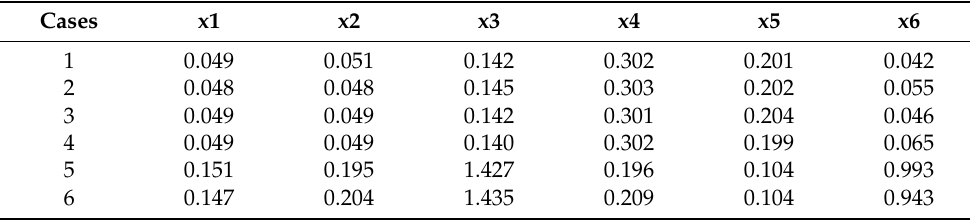
Table 4. Calculated average concentration of Cu in scrap, C Cu , j , in six scrap types ( x j ) using the NNLS method.